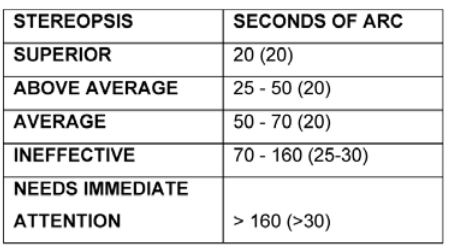
Table 3: The norms for stereopsis with the use of a Randot Stereo Test. The results in brackets are the results obtained by Buys 4 .